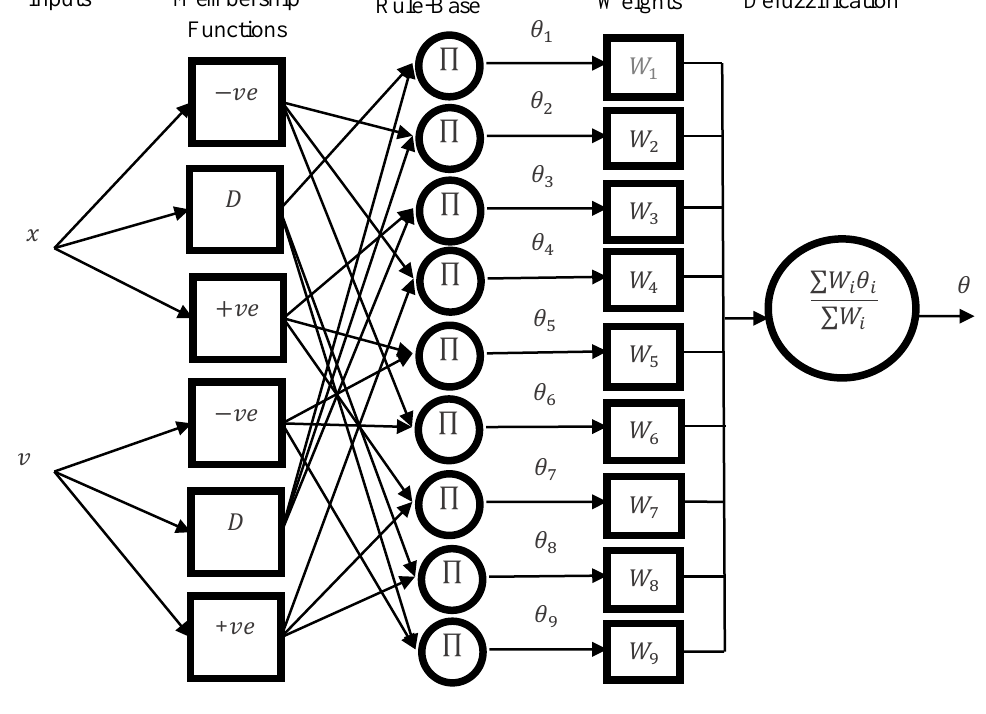
Fig. 5. Model of ANFIS